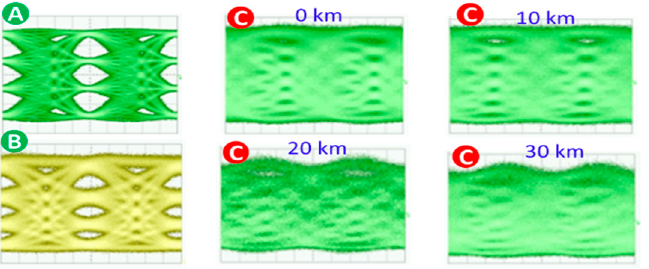
Figure 2. The eye diagrams (10 ps/div time resolution) obtained at the output of the DAC (marker A ), the modulator (marker B ), and the photodiode (marker C ), respectively.